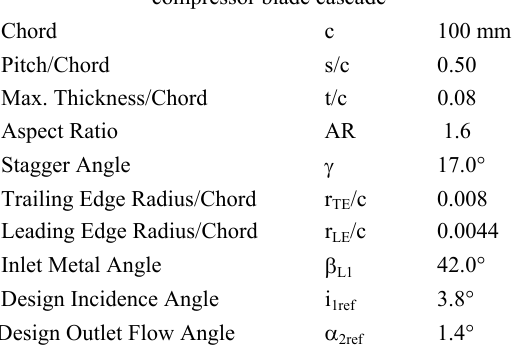
Table 2: Characteristic dimensions of the